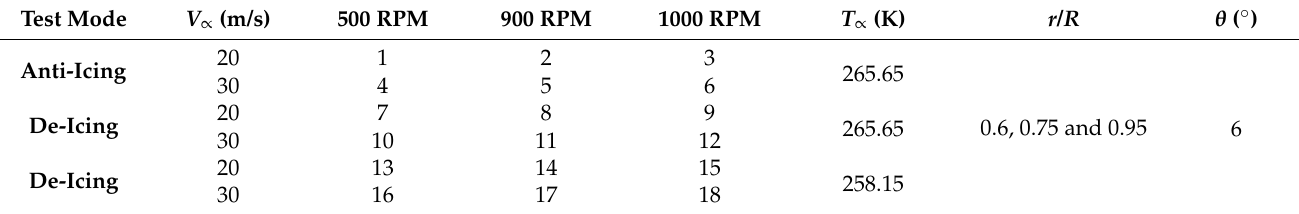
Table 2. Rotor Test Plan with Specific Test ID#.